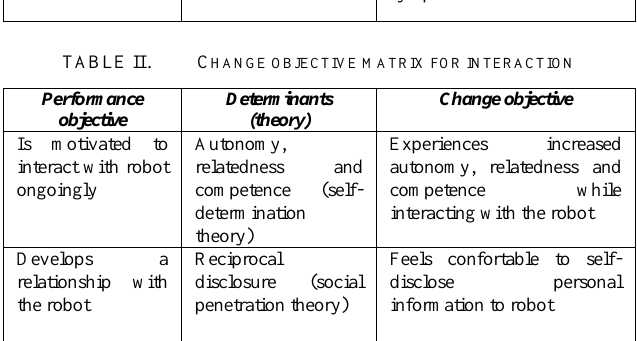
C HANGE OBJECTIVE MATRIX FOR INTERACTION Performance objective